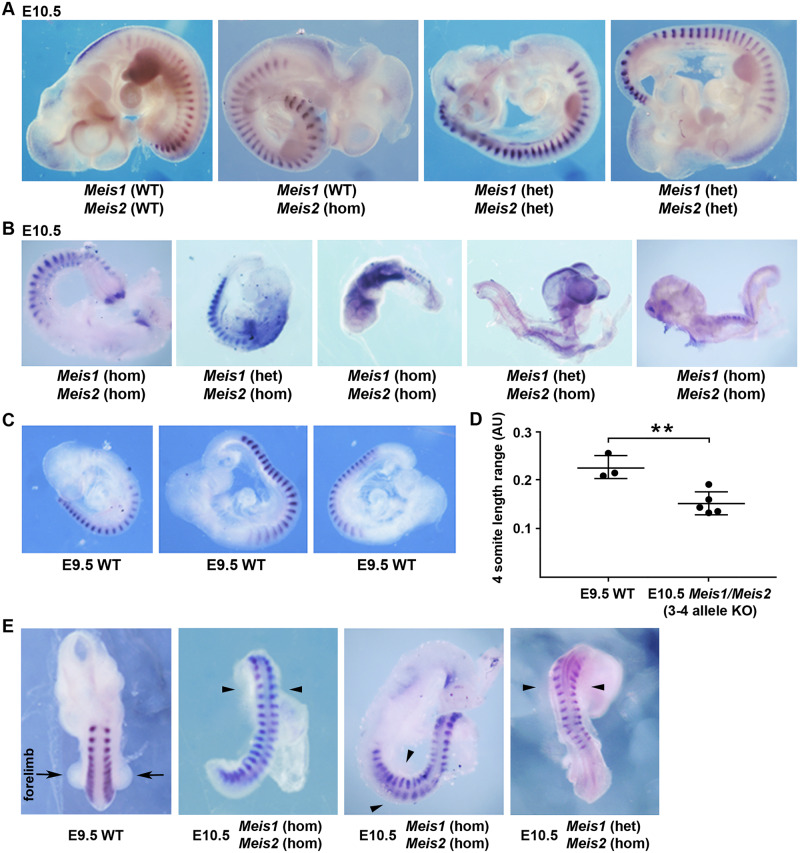
Meis1/Meis2 double mutants exhibit defects in body axis and forelimb formation.(A) Embryos dissected at E10.5 carrying 0–2 KO alleles for Meis1 or Meis2 have normal somites and body axis formation based on expression of the somite marker Uncx; also, limb formation is normal. (B) Embryos dissected at E10.5 and stained for Uncx that carry 3 or 4 KO alleles for Meis1 or Meis2 exhibit small somites and reduced body axis growth resembling the size of embryos at E9.5. (C) WT E9.5 embryos stained for Uncx expression. (D) Comparison of somite size along the anteroposterior axis between E9.5 WT and E10.5 Meis1/Meis2 KO embryos (3–4 KO alleles); *p < 0.05, data expressed as mean ± SD, 1-way ANOVA (nonparametric test); WT, n = 3 biological replicates; Meis1/Meis2 3–4 allele double KO, n = 5 biological replicates. (E) Forelimb buds (arrows) normally observed in an E9.5 WT embryo are absent in E10.5 Meis1/Meis2 KO embryos with 3–4 knockout alleles (arrowheads). Data associated with this figure can be found in S1 Data. AU, arbitrary units; E, embryonic day; het, heterozygous; hom, homozygous; Meis1, Meis homeobox 1; Meis2, Meis homeobox 2; KO, knockout; SD, standard deviation; WT, wild-type.